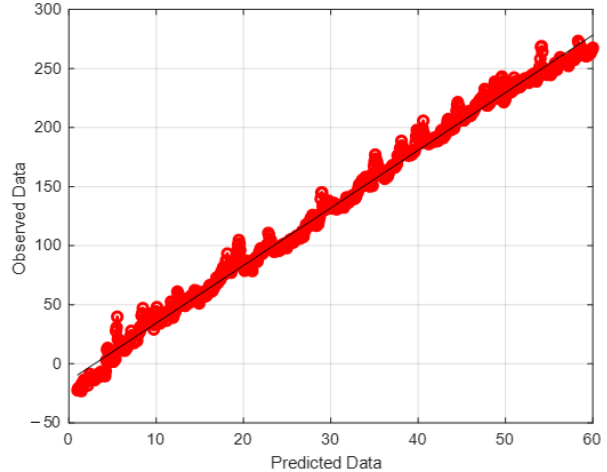
Figure 14. Distribution of data.